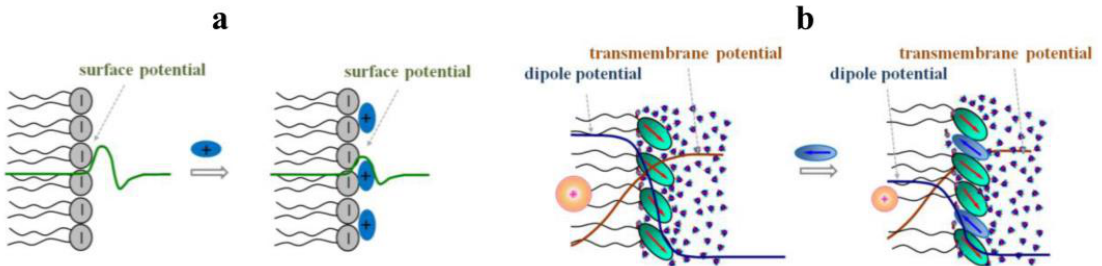
Figure 4. The schematic representations of the decrease in the absolute value of membrane surface (green curves) ( a ) and dipole (dark blue curves) potential ( b ) at addition of phytochemicals (blue ovals). The applied transmembrane voltage (brown curves) remains constant while dipole potential profile is altered due to the adsorption of the plant molecules. This results in dramatical changes in the inter-membrane electric potential, which is shown as virtual plus in the center of hydrocarbon core (orange cycle).